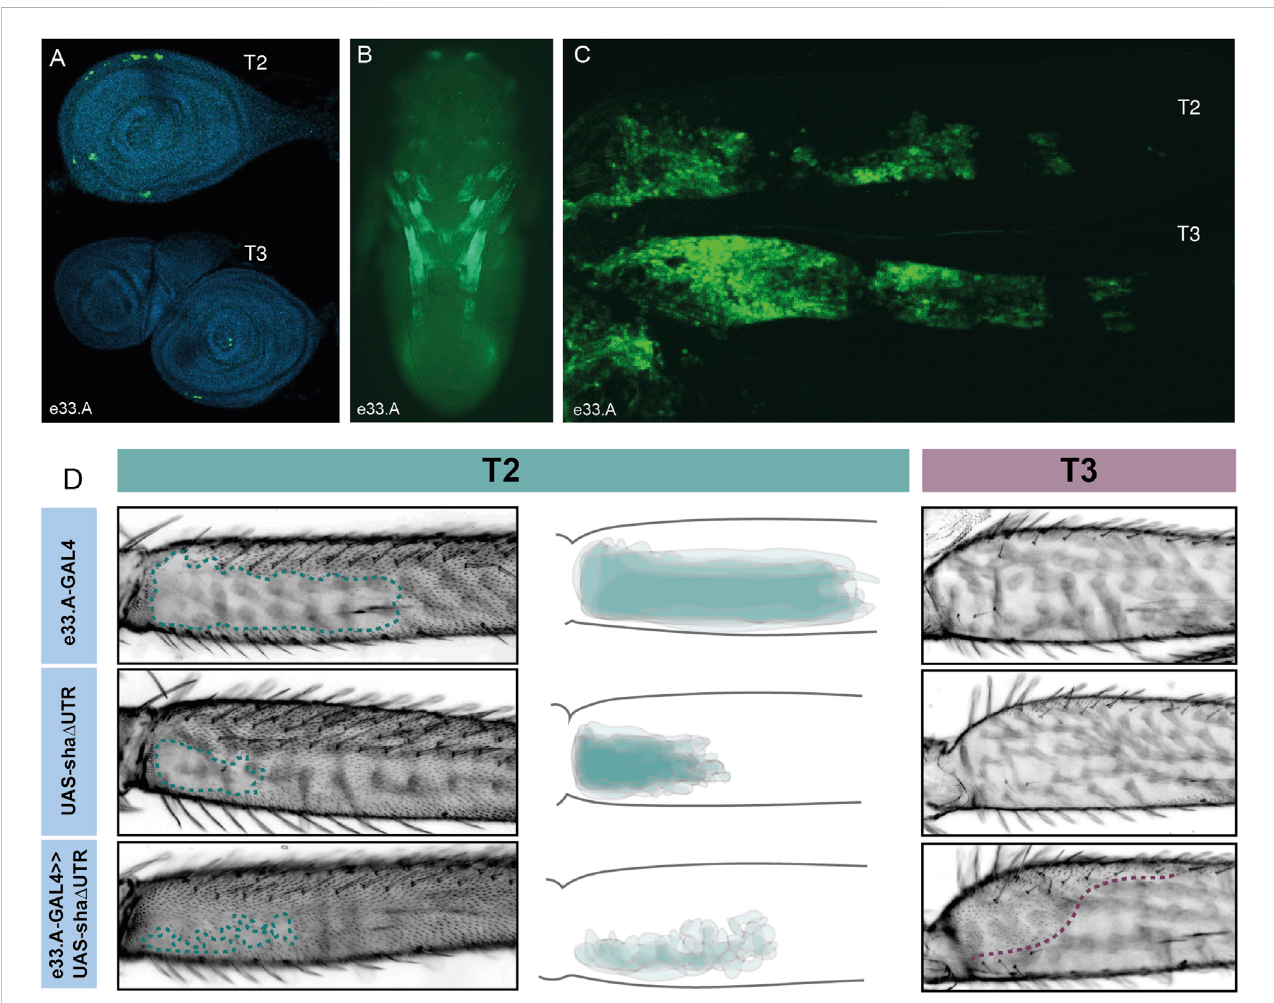
FIGURE 3 Characterisation of e33.A enhancer activity. (A) Expression driven by e33.A in T2 and T3 leg imaginal discs from 3rd instar larvae is restricted in comparisontothewholeVT42733enhancer.ThereisalsoreducedexpressioninT3comparedtoT2. (B) Inwholepupaeat24hAPF,e33.Adrivesmainlyinthe developing legs. (C) In T2 and T3 pupal legs at 24 hAPF, there is clear expression driven by e33.A in the femur. (D) The result of crossing e33.A to the trichome activating line, UAS-sha Δ UTR. On T2 legs (labelled in green), there is patchy ectopic trichome development in the NV when compared with